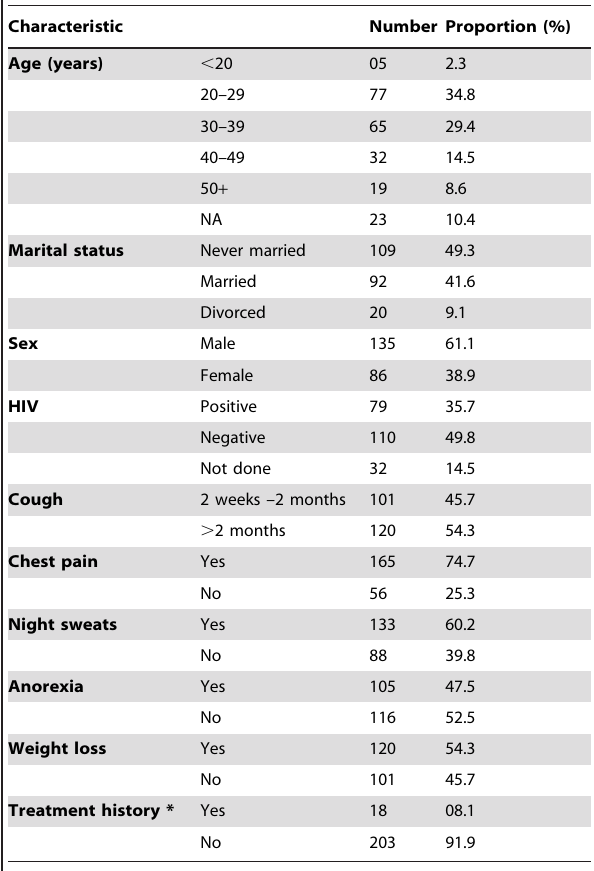
Table 1. Socio-demographic characteristics of 221 patients who attended Assessment Centre and the TB clinic, Mulago Hospital complex, between January and April inclusive, 2011.